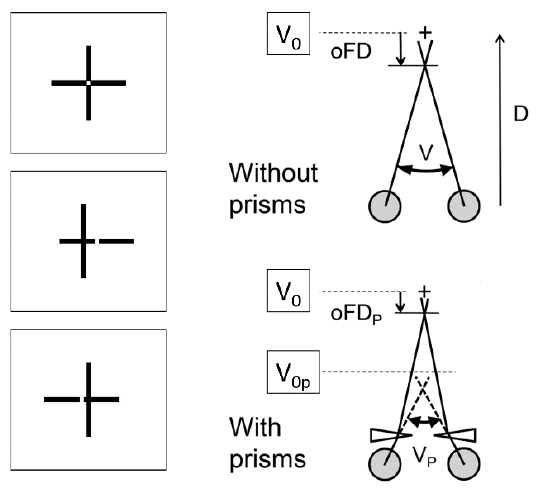
Figure 1: (Left) Cross test with the vertical and horizontal lines in alignment and with an offset to the left and to the right. The angular amount of the offset at perceived alignment represents the subjective fixation disparity. (Right) The eye tracker measures the vergence angle V between the visual axes. The deviation of V from the stimulus vergence angle V 0 is the objective fixation disparity. The prism introduces a shift of the vergence stimulus from V 0 to V 0p . The angles are not to scale. For more details see Schroth et al.